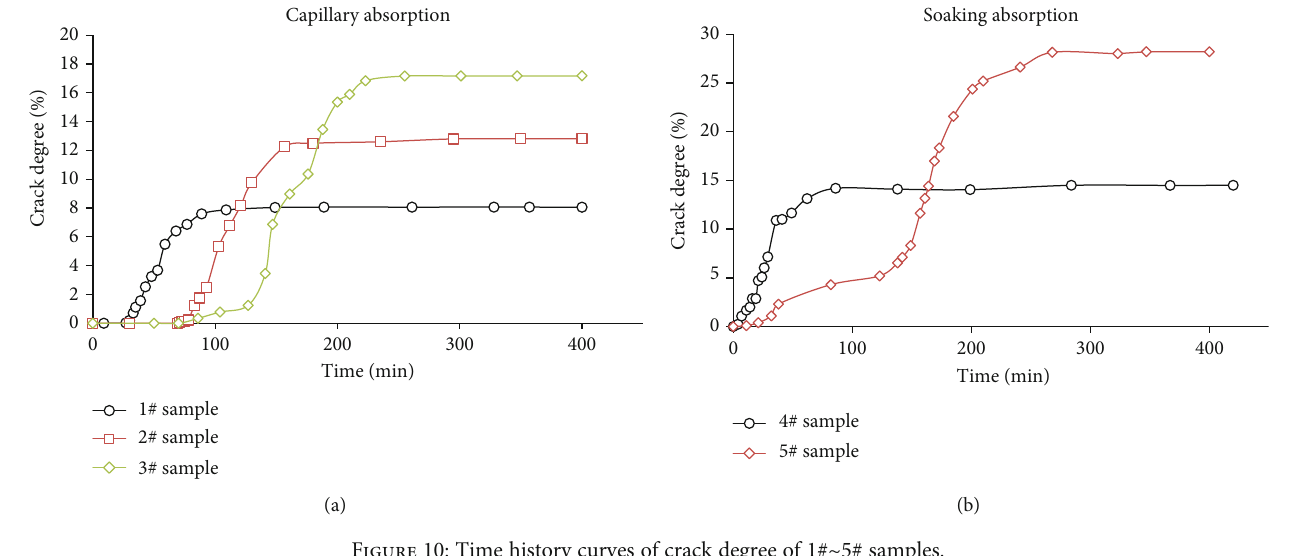
Figure 10: Time history curves of crack degree of 1# ~ 5# samples.